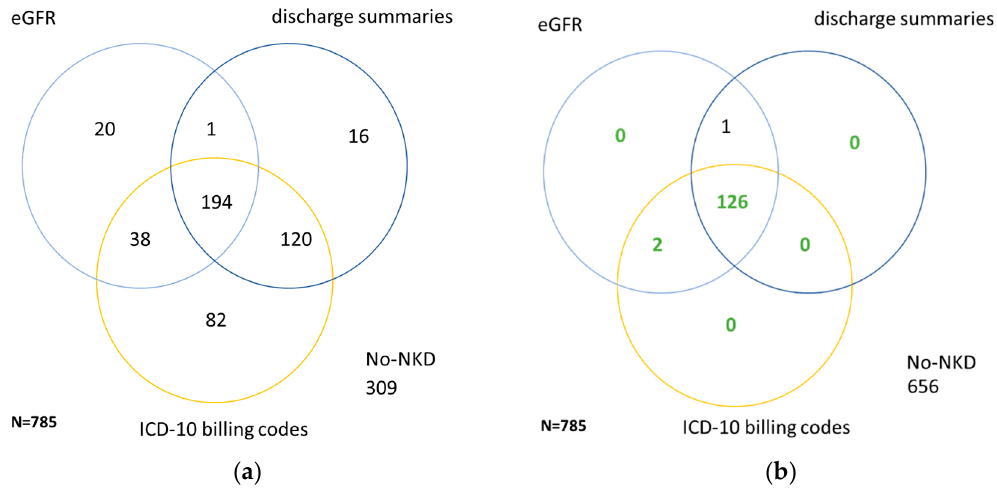
Figure 2. Venn diagrams comparing identification of no known kidney disease (NKD) by laboratory